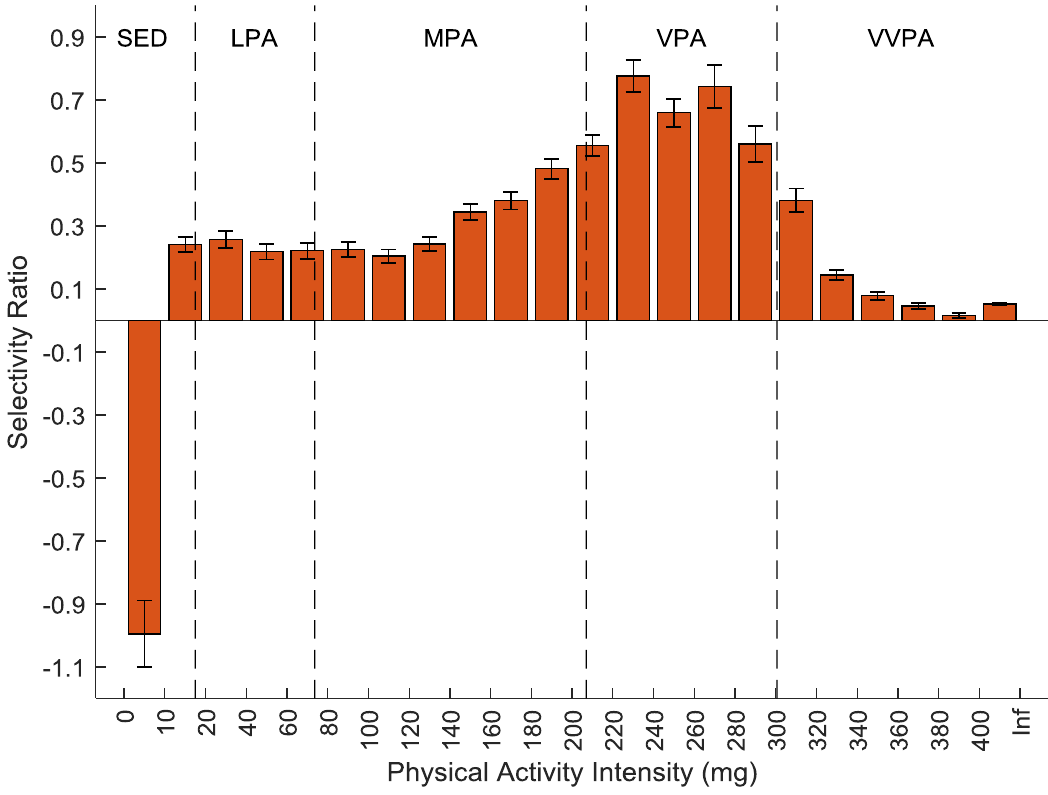
Figure 2. Selectivity ratio plot with confidence intervals of the association between each physical activity intensity variable (bin) using the ActiGraph filter and the cardiometabolic health composite store (CS). A positive bar indicates more time spent at that intensity is associated with higher CS and a negative bar indicates more time spent at that intensity is associated with lower CS. Traditional intensity classification as reference; SED, sedentary; LPA, light physical activity; MPA, moderate physical activity; VPA, vigorous physical activity; VVPA, very vigorous physical activity; Inf, infinity.